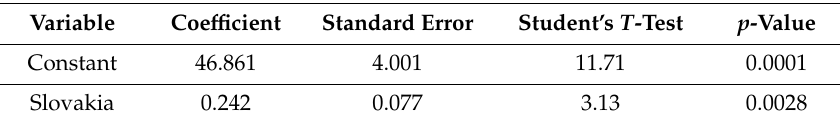
Table 6. Parameters of the regression model for Slovenian prices (dependent variable) being explained by Slovak prices (independent